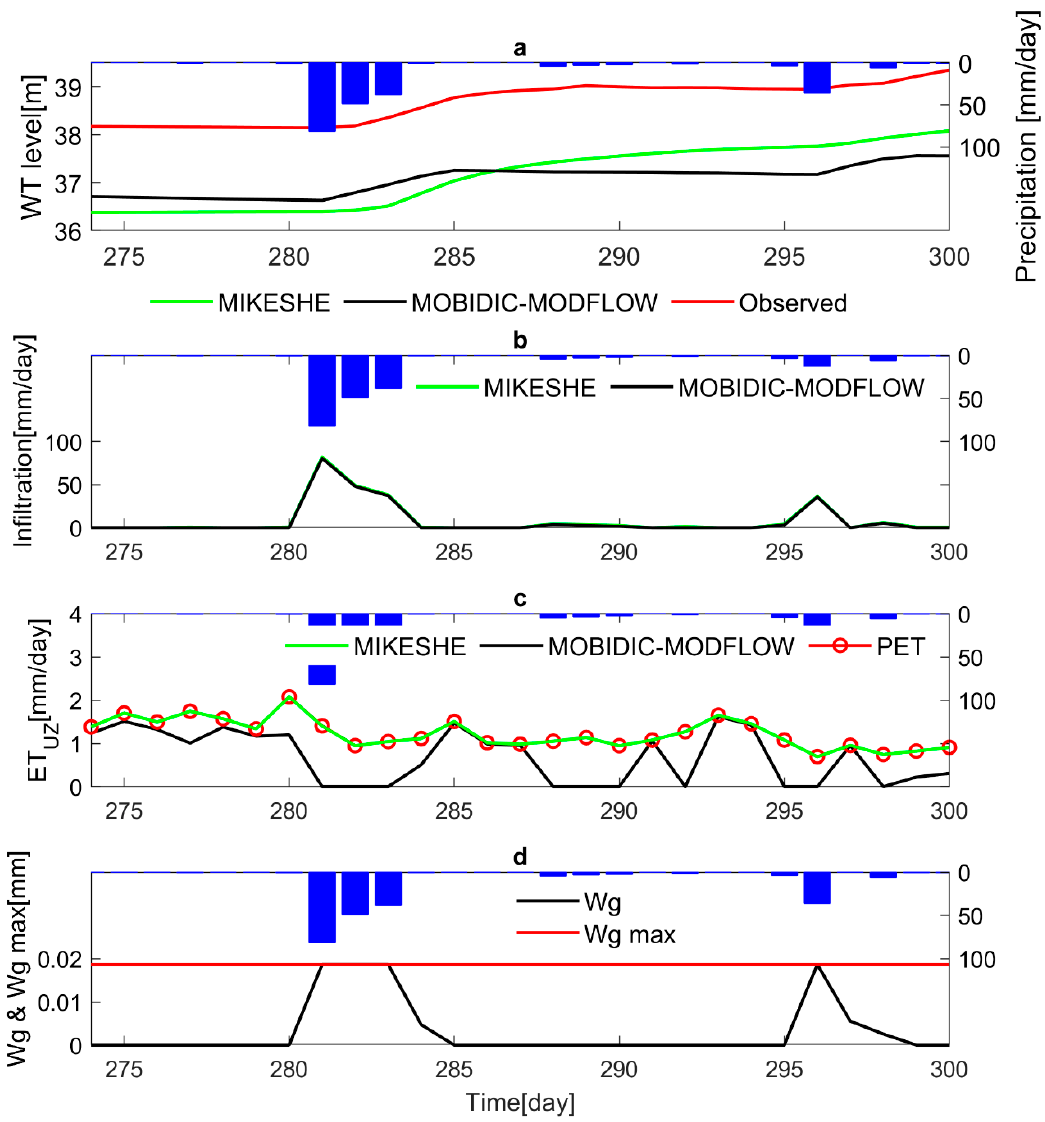
Figure 11. ( a ) Observed (red) and simulated groundwater head with MIKE SHE (green) and with MOBIDIC-MODFLOW (black) between days 274 and 300 at Malcom. ( b ) Infiltration rate simulated with MIKE SHE (green) and MOBIDIC-MODFLOW (black). ( c ) Evapotranspiration from the unsaturated zone simulated with MIKE SHE (green) and MOBIDIC-MODFLOW (black) and ( d ) time evolution of gravity reservoir in MOBIDIC-MODFLOW (black) along with the maximum storage capacity of the gravity reservoir (red).